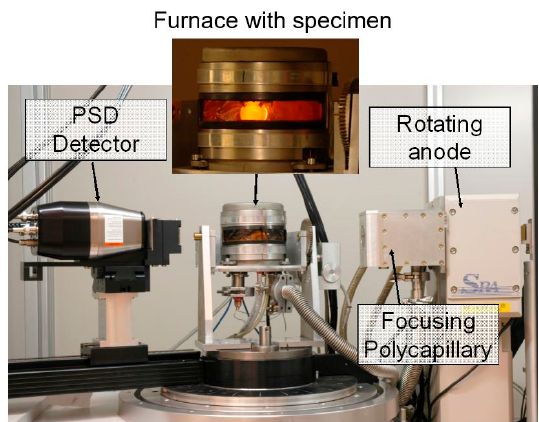
Figure 1. Diffractometer used for in-situ X-ray measurements with furnace (enlarged with glowing sample). ◦ Exemplarily, the di ff raction patterns for 20, 300, and 500 C are shown for SAE 52100 in Figure 2. ◦ At 20 C, 20 ma.% austenite, 3 ma.% cementite, and 87 ma.% martensite could be detected. The austenite ◦ ◦ peak vanished at 300 C. At 500 C, the cementite increased to an amount of 10 ma.%. The